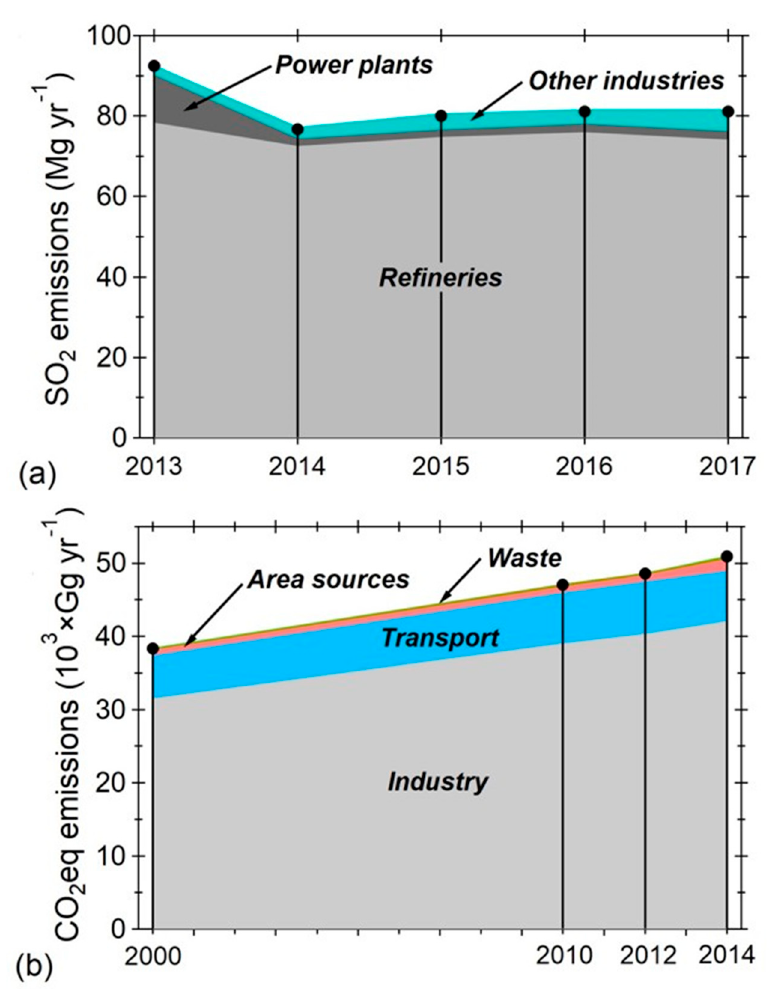
Figure 11. Singapore’s SO 2 and GHG emission evolution. The annual emissions of SO 2 in 2017 accounted for 81,036 Mg, while the emissions of GHG in 2014 for 50,908 Gg CO 2 eq including emissions of CO 2 , CH 4 , N 2 O, HFCs, PFCs, and SF 6 . The green areas acted as net source of GHG and contributed 0.1% to the total emissions [129,133].